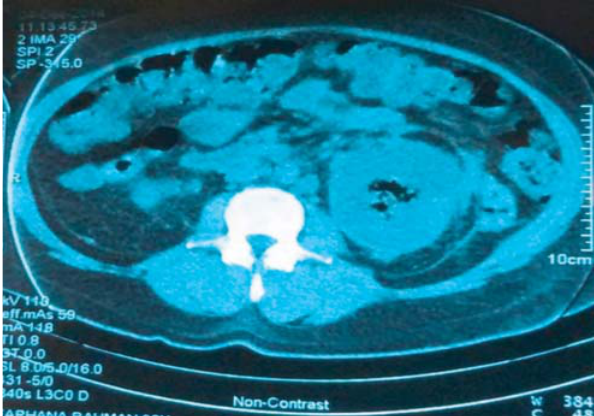
Fig 3A. CT scan of abdomen showing gas in left renal pelvis and parenchyma